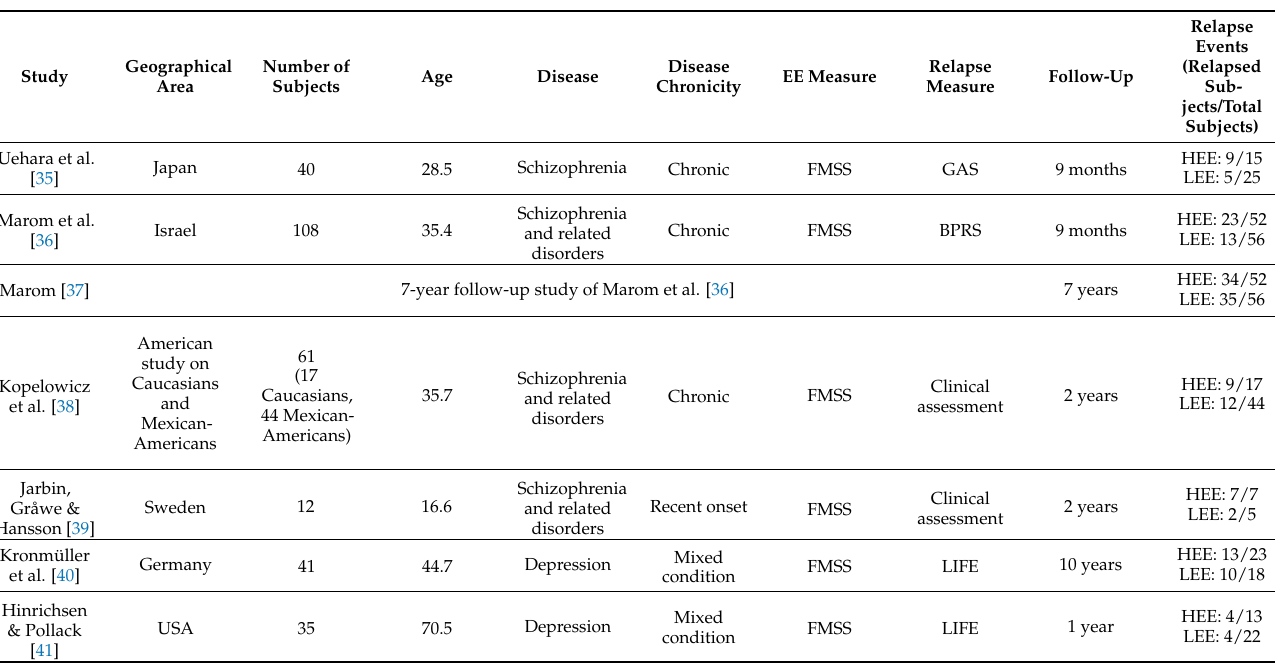
Table 1. Characteristics of the six studies examining the association between EE and relapse in patients with schizophrenia and major